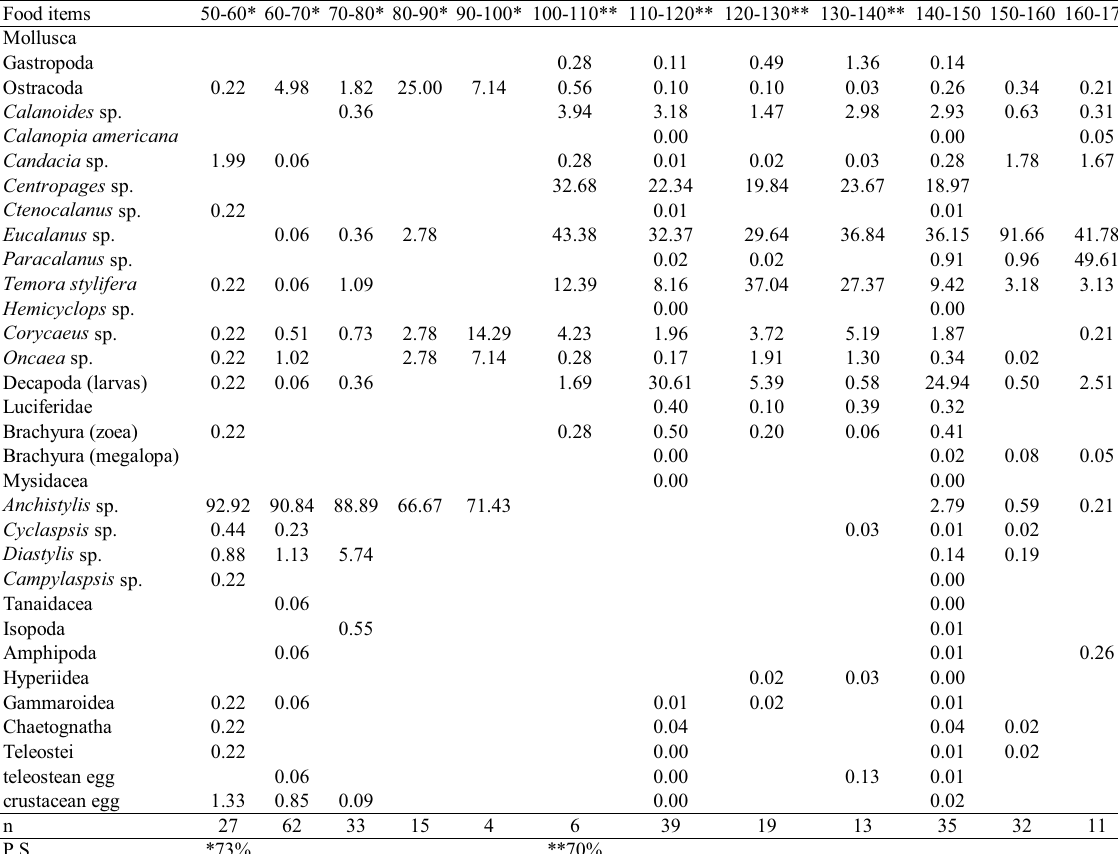
Table 4. Diet composition of Trachurus lathami expressed by feeding index (FI%) according of lenght classes (mm) of fish